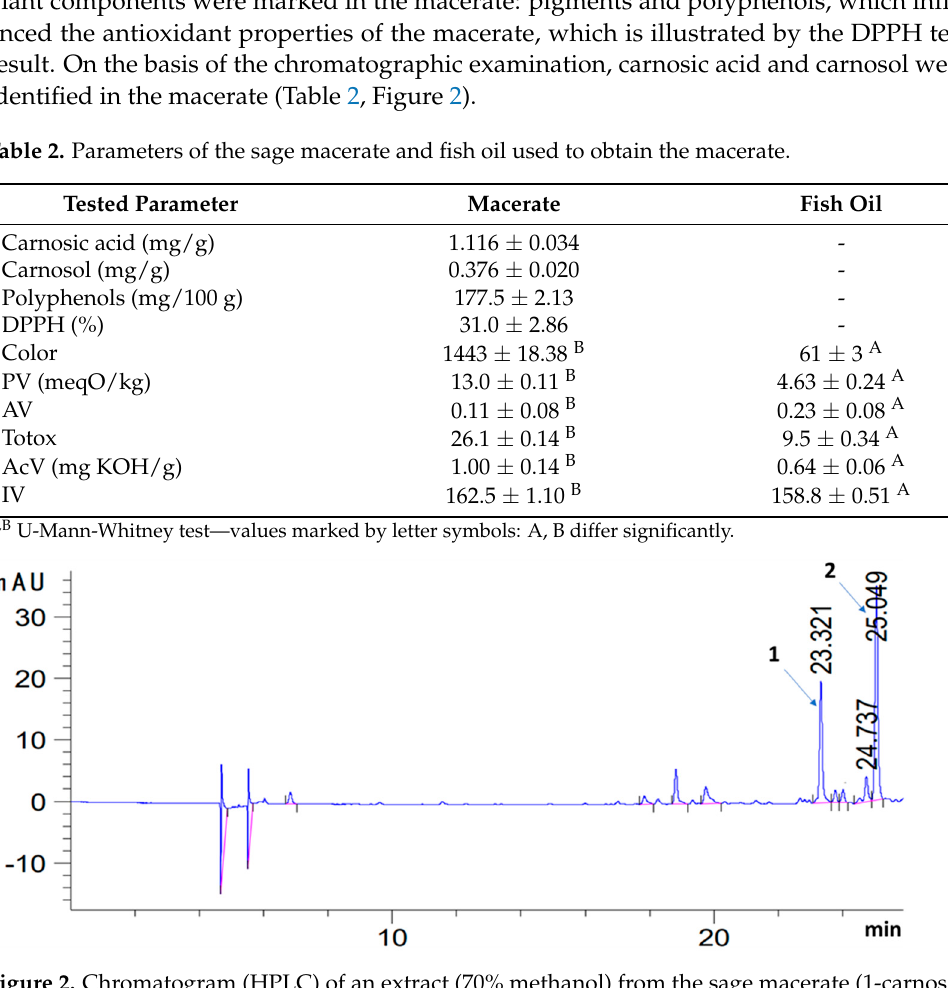
Figure 2. Chromatogram (HPLC) of an extract (70% methanol) from the sage macerate (1-carnosol, retention time—23.321 min; 2-carnosic acid, retention time—25.049).